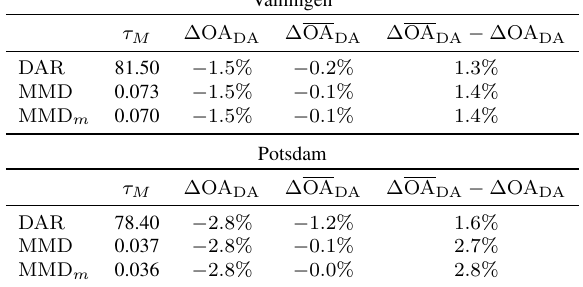
Table 3: Domain adaptation results over the Vaihingen and Pots- dam dataset after applying threshold τ M for negative transfer prediction. ∆OA DA : average loss in OA before applying the strategy. ∆OA DA : loss in OA after negative transfer prediction.